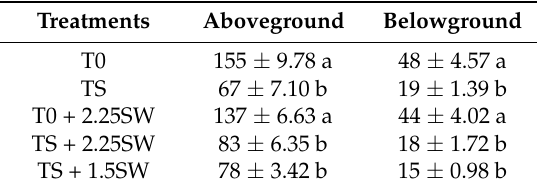
Table 2. Aboveground (leaves and steam) and belowground (roots) of 2 year old Hass avocado plants grown in pot under different salt and seaweed extract conditions (T0: distilled water, TS: saline water (9 mM NaCl), T0 + 2.25SW: distilled water + 2.25 mL seaweed, TS + 2.25SW: saline water (9 mM NaCl) + 2.25 mL seaweed T0 + 1.5 mL seaweed) for 240 days, with 6 replicates per treatments. Treatments Aboveground Belowground T0